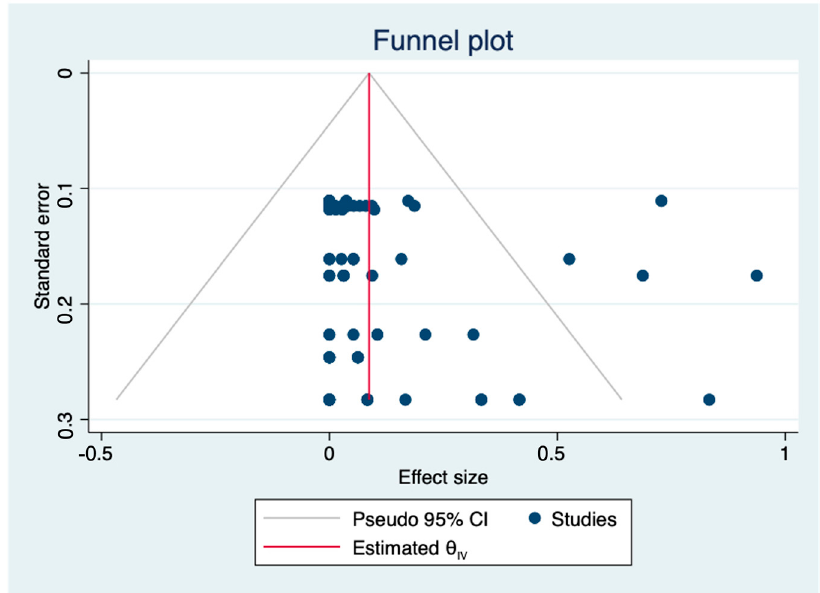
Figure 4. Funnel plot of the association between estimated effect sizes and standard errors in a single study of prevalence of antimicrobial resistance. ( θ IV : summary estimate).